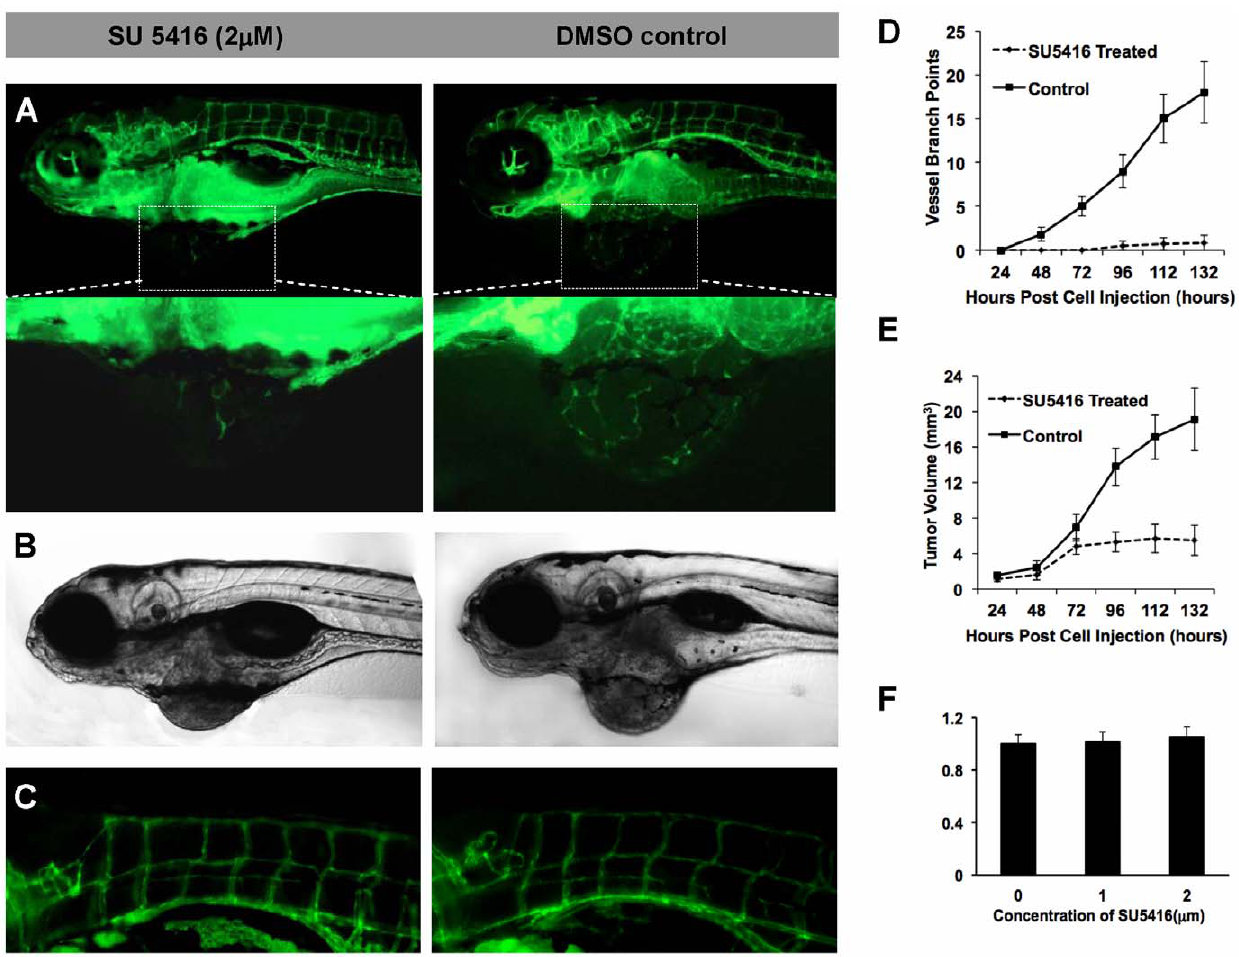
Figure 6. The small-molecular inhibitor of VEGFR2 inhibiting the tumor growth and neovascularization. (A–C) The imaging showed the obvious blockage of the specific inhibitor of VEGFR2, SU5416 (2 m M), to the neovascularization (A), tumor growth (B), and normal vascular vessels of zebrafish (C). (D,E) The quantitative analysis of the inhibiting effects of SU5416 to neovascularization (D) and tumor growth (E). (F) The result of MTT assay for B16 cells that treated by SU5416 for 48 hours in vitro at a concentration of 0, 1, 2 m M. Scale bar, 100 m